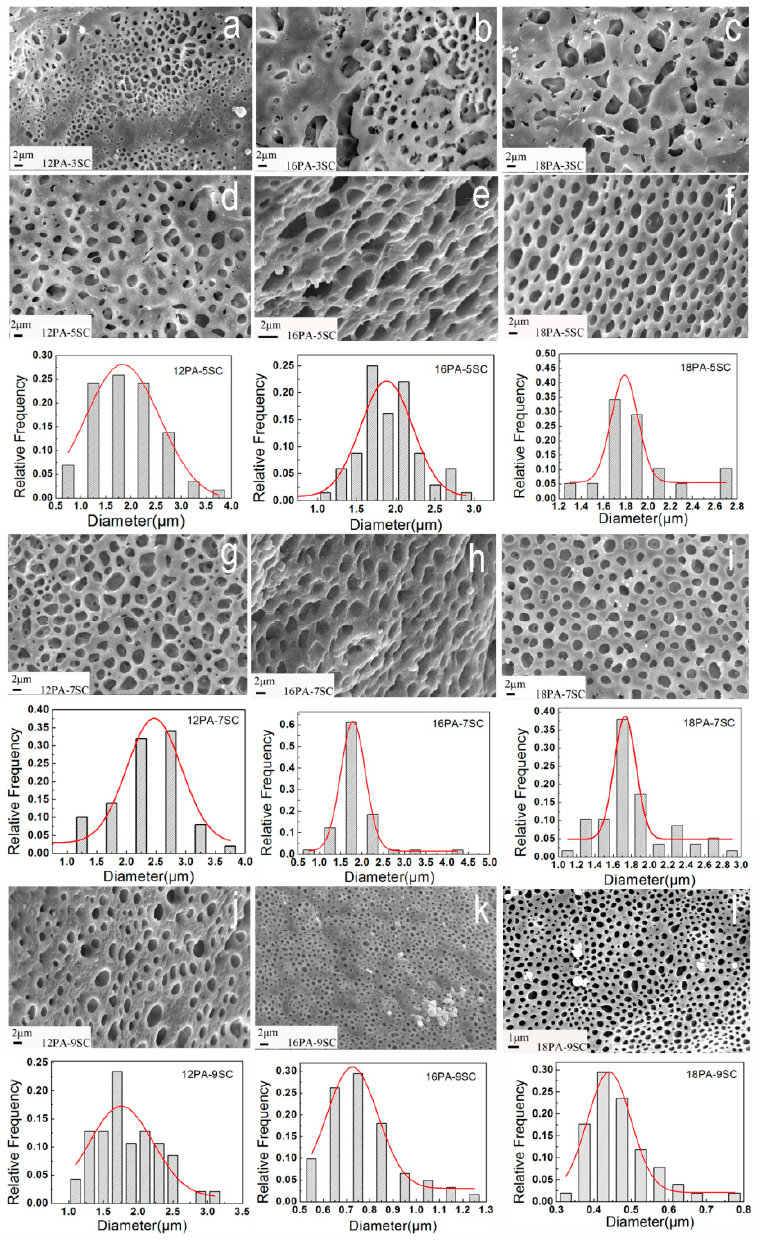
Figure 2. SEM images of PA foams with different compositions and their corresponding pore's size distribution: ( a ) 12PA-3SC; ( b ) 16PA-3SC; ( c ) 18PA-3SC; ( d ) 12PA-5SC; ( e ) 16PA-5SC; ( f ) 18PA-5SC; ( g ) 12PA-7SC; ( h ) 16PA-7SC; ( i ) 18PA-7SC; ( j ) 12PA-9SC; ( k ) 16PA-9SC; ( l ) 18PA-9SC.